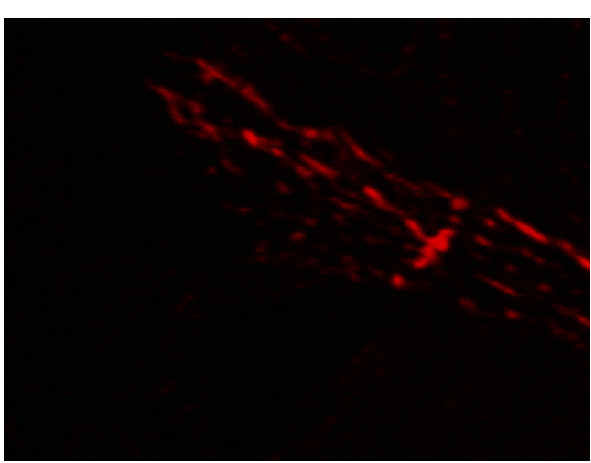
FIGURA 2 – Imagem de corte histológico da área de anastomose em animal do grupo I+An, corado pelo picro sirius red e observado com filtros analisador e polarizador